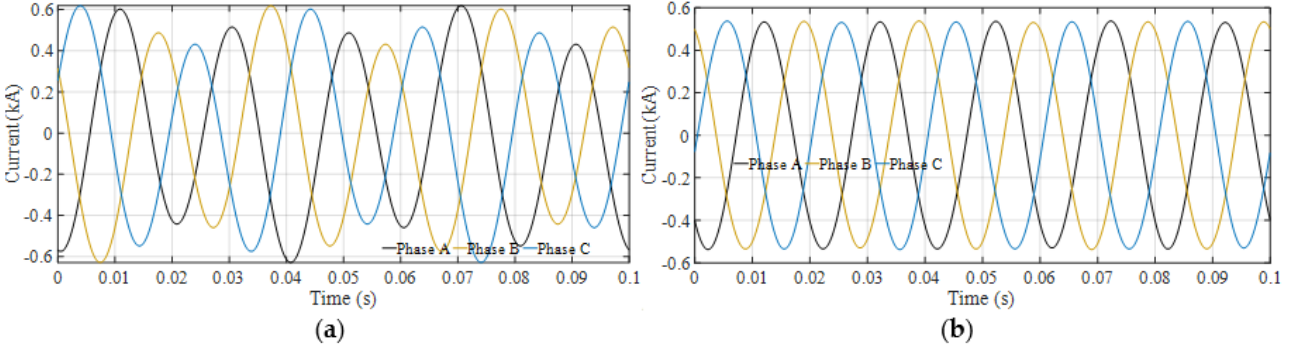
Figure 27. Three-phase current signals at the secondary side of the substation. ( a ) Deformed by harmonic and ( b ) operating EVs as active